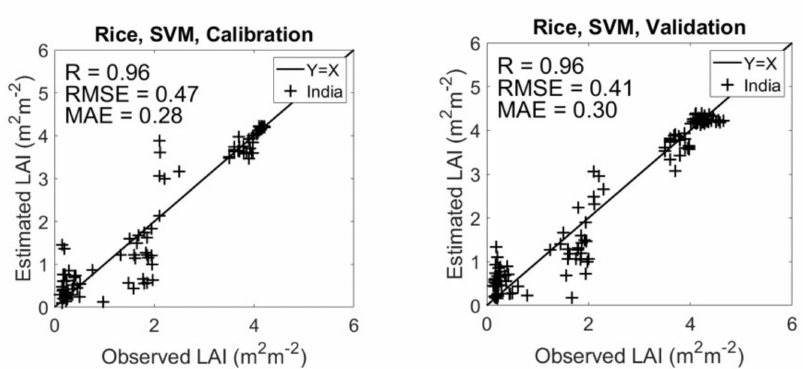
Figure 5. The calibration and validation results for rice for the JECAM India